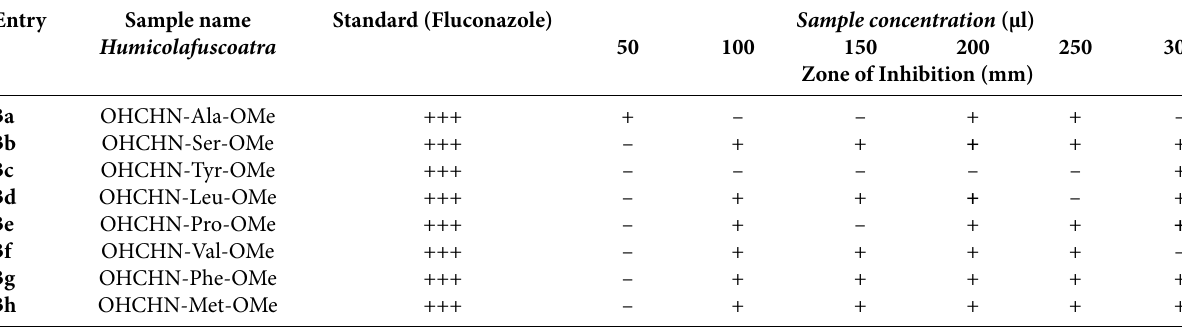
Table 4. Antifungal activity of standard and samples employing Humicolafuscoatra